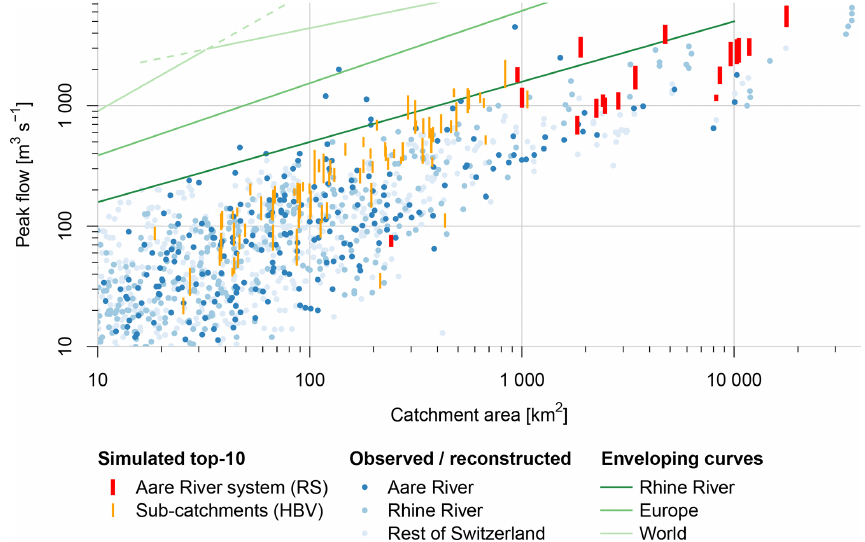
Figure 12. Range of the top-10 flood peaks simulated based on GWEX scenarios with the median representative parameter set for each output node of the Aare River system (RS MINERVE output, red) and each sub-catchment (HBV output, orange), in comparison to observed and reconstructed peak discharges (Eidgenössisches Amt für Strassen- und Flussbau, 1974; Kienzler and Scherrer, 2018), separately for the Aare River basin (dark blue), the Rhine River basin (without sites in the Aare River basin) (medium blue) and the rest of Switzerland (light blue). For orientation, enveloping curves are shown for the Rhine River basin (Vischer, 1980, here including the Aare River basin; valid for catchments with an area of up to roughly 10000km 2 ), Europe (Marchi et al., 2010) and the world (Herschy,